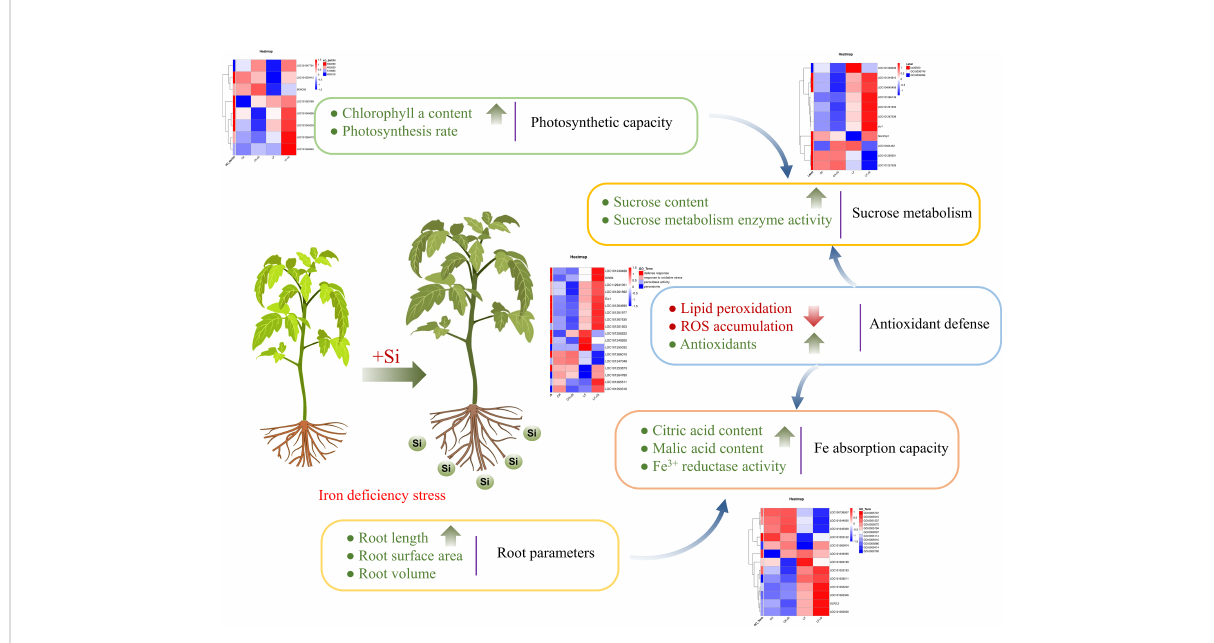
FIGURE 9 A working model of the effect of Si application on tomato under Fe de fi